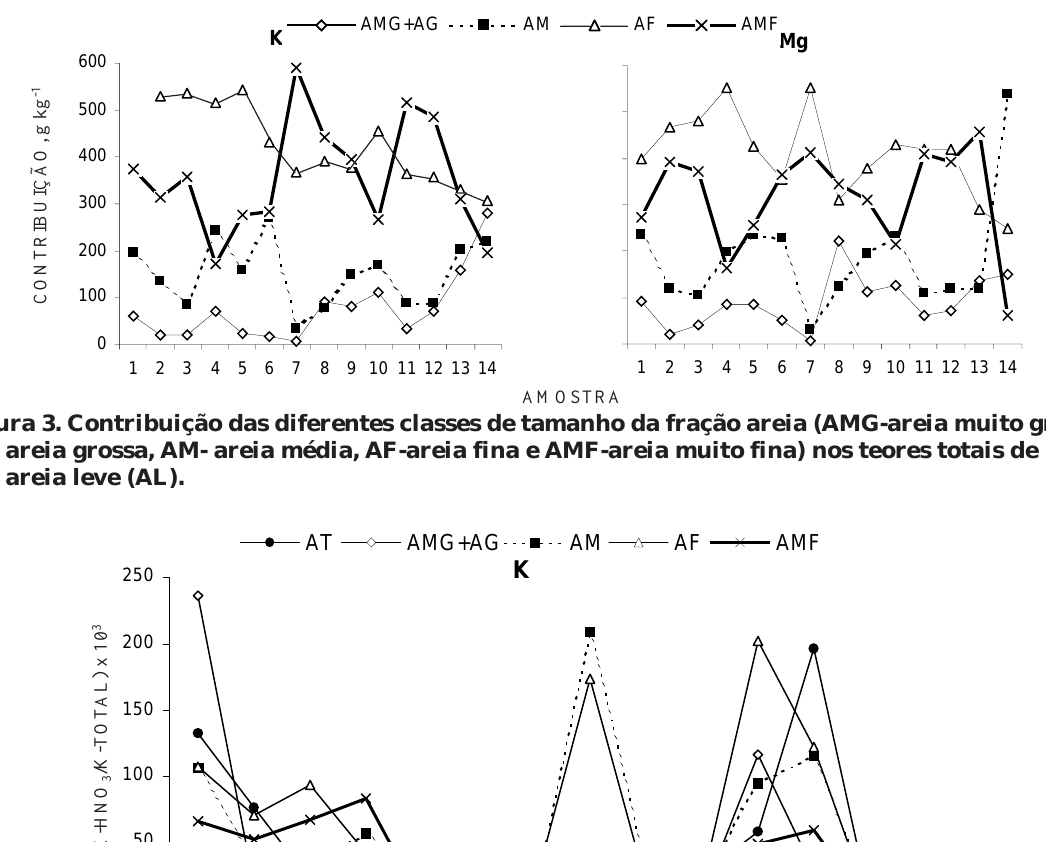
Figura 4. Relação entre K extraído pelo HNO 1 mol L -1 (K não-trocável) e pelos ácidos: fluorídrico, nítrico 3 e sulfúrico (HF) (K total) na areia total (AT) e nas subdivisões da areia leve (AMG + AG-areia muito grossa + areia grossa, AM-areia média, AF-areia fina e AMF-areia muito fina).